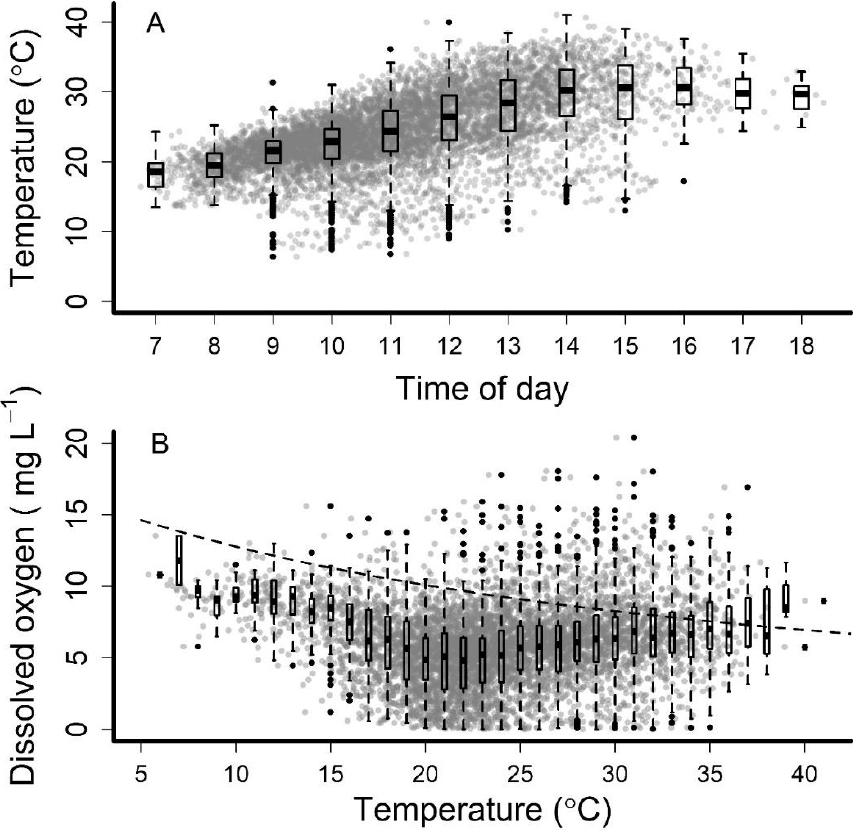
Figure 2. Water temperature of isolated pools by time of day ( A ) and dissolved oxygen by water temperature ( B ) that formed during streamflow intermittency in the Middle Rio Grande, New Mexico, June through October from 2011 to 2016. Individual pools are represented by gray dots and box-and-whisker plots depict the median (bar), interquartile range (box), points within 1.5 times the interquartile range (whiskers), and outliers (black dots). The dashed trendline represents the effect of temperature on solubility of oxygen in freshwater (chlorine and salinity = 0 ppm) at 760 mm Hg [68].